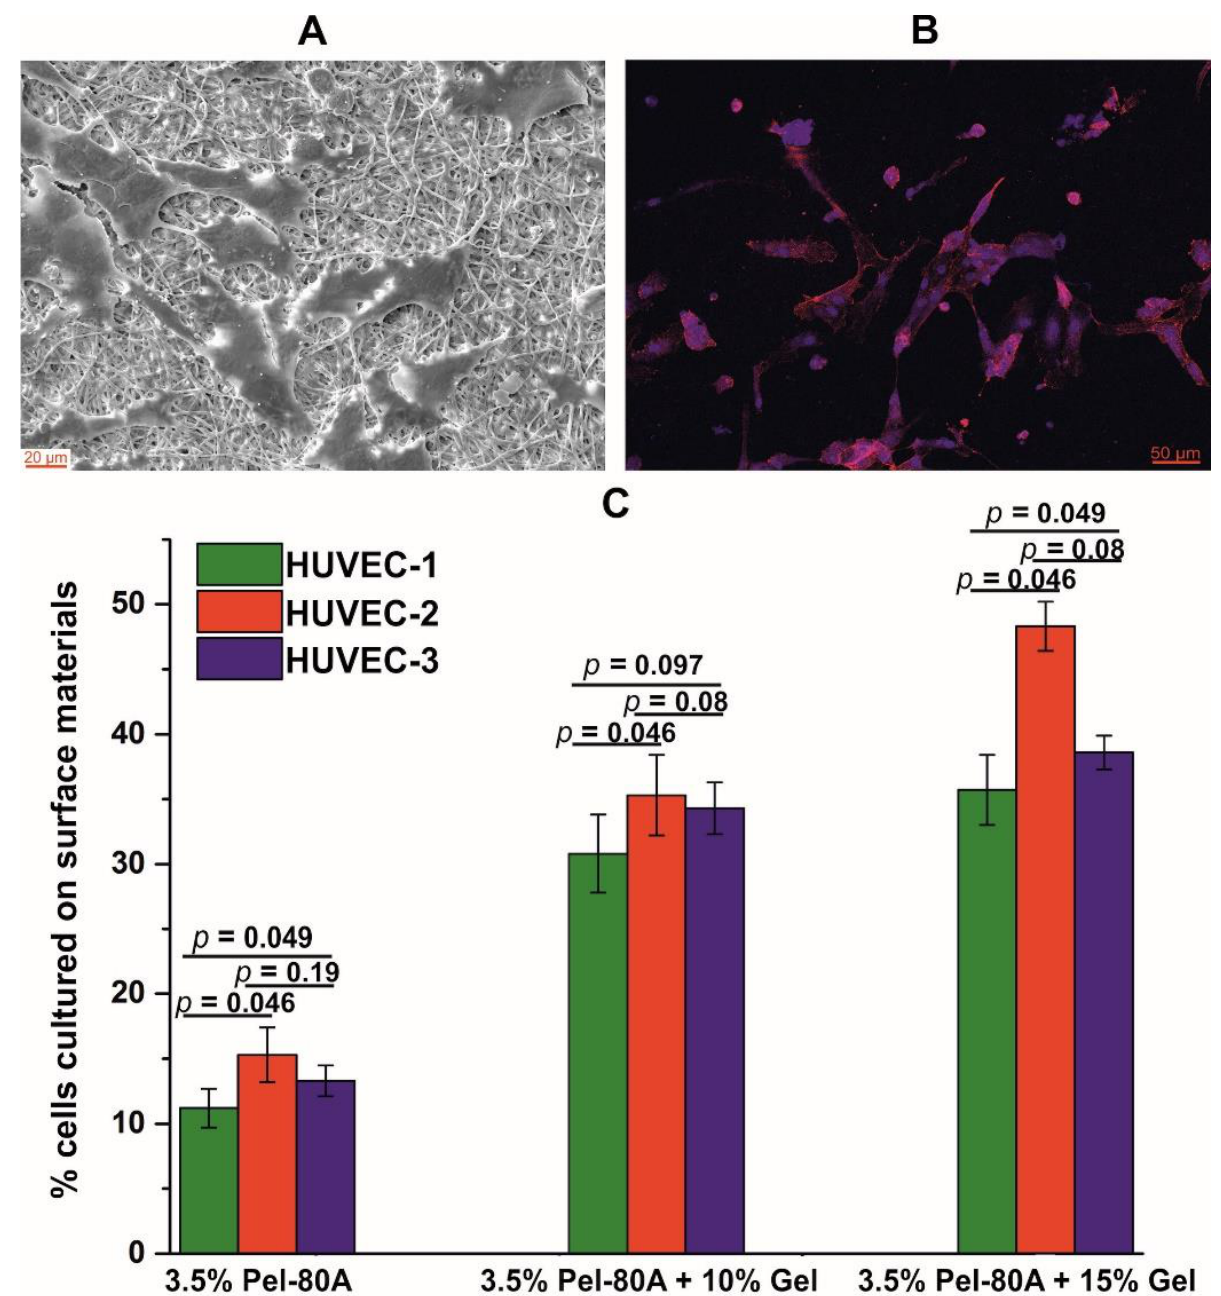
Figure 2. Interaction of endothelial cells with electrospun Pel-80A-based scaffolds. SEM image of endothelial cells cultured on 3.5% Pel-80A + 10% Gel scaffold ( A ). Fluorescence image of cell morphology of HUVEC cultured on the surface of the scaffold containing 3.5% Pel-80A + 15% Gel (nuclei and actin filaments of cells stained with Hoechst 33342 and Phalloidin- TRITC dye, respectively) ( B ). Viability of HUVEC from 3 different donors on the surface of different 3D matrices after 48 h of cultivation (data are presented as the mean of three replicates with standard deviation) ( C